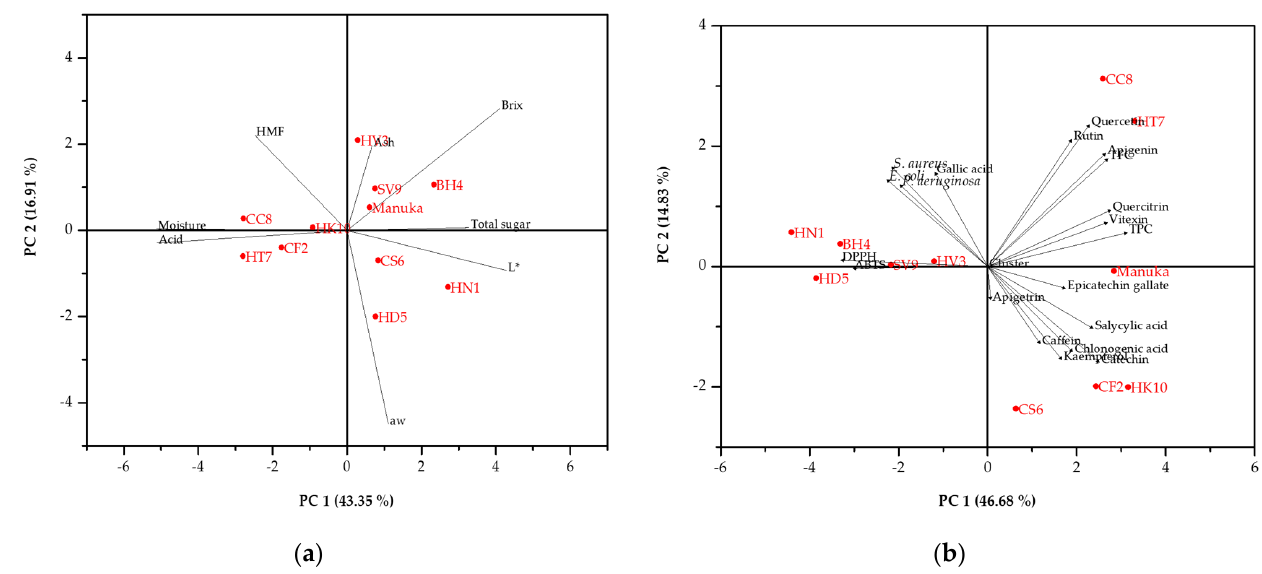
Figure 5. Principal component analysis (PCA) biplot for ( a ) Physical-Chemical parameter and ( b ) Total phenolic and flavonoid contents (TPC and TFC), antioxidant activity, antimicrobial activity and phenolic compounds of different honeys.